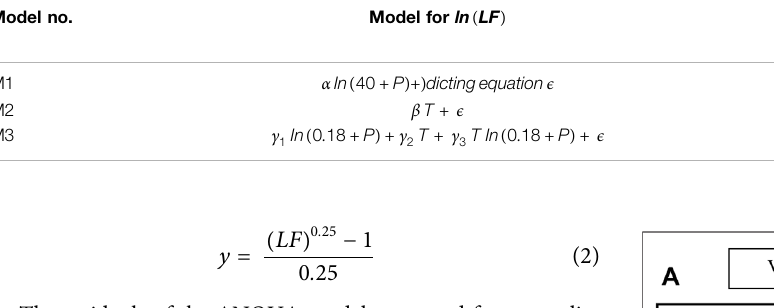
TABLE 2 | Linear regression models for ln ( LF ) and predicting functions for. LF Model no.